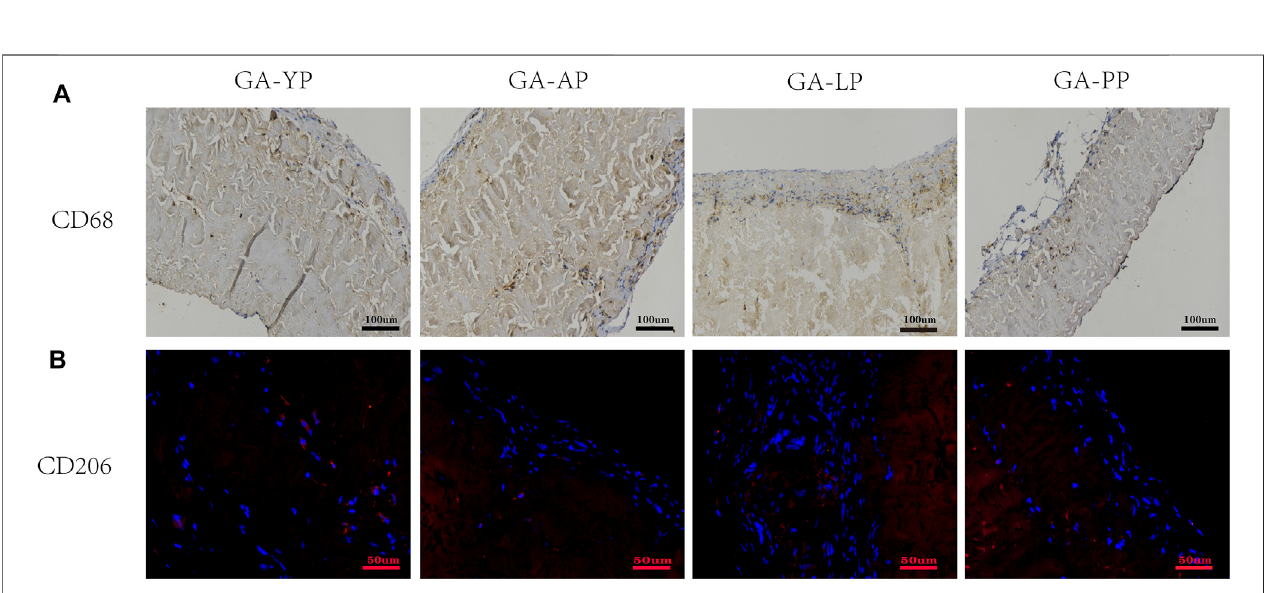
FIGURE 13 | Eight weeks after subcutaneous implantation, immunohistochemistry and immuno fl uorescence were used to observe the different types of macrophage markers, (A) CD68 (M1phenotype brown) scale bars are 100 um. (B) , CD206 (M2 phenotype, red) scale bars are 50 um.